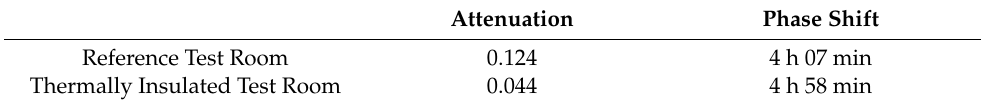
Table 6. Attenuation and Phase-Shift Average Values Obtained under Free-Floating Conditions.